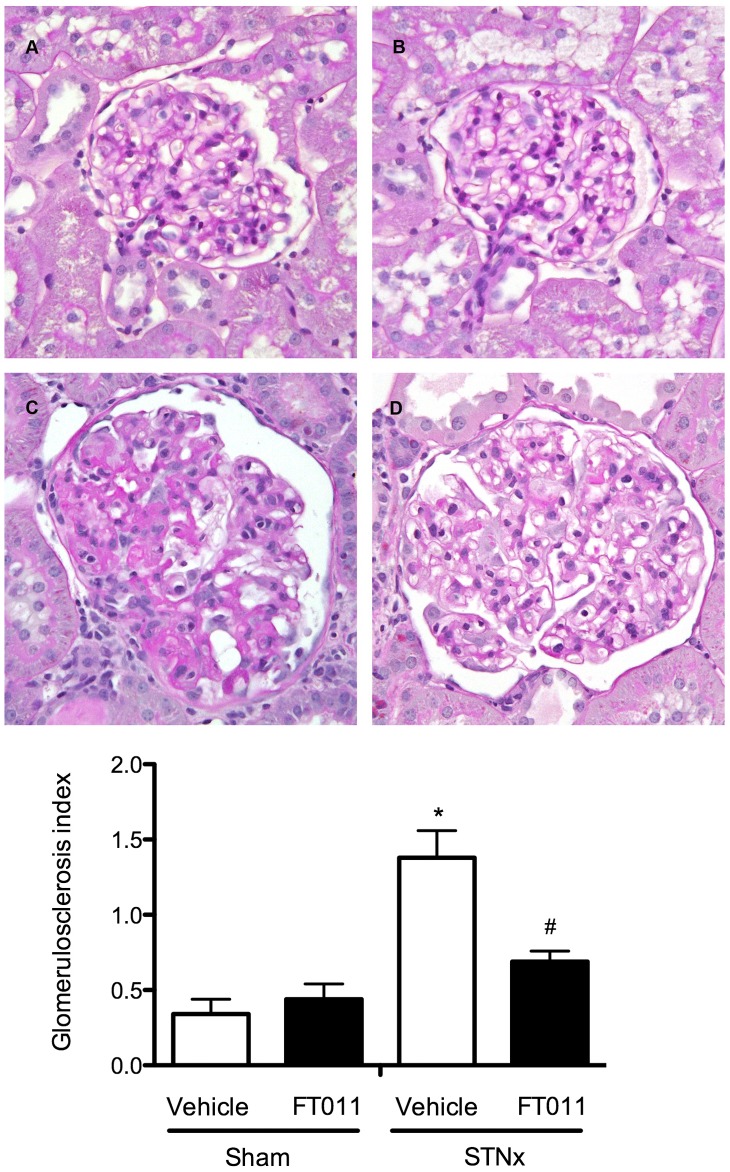
Representative photomicrograph of PAS stained sections from STNx rats.Representative photomicrograph of PAS stained sections from sham and STNx rats treated with and without FT011. In sham (A) and sham treated with FT011 rats (B), there was minimal glomerulosclerosis, while STNx rats (C) was associated with an increase in glomerulosclerosis. Treatment of STNx rats with FT011 (D) was associated with a reduction in extent of glomerulosclerosis. Magnification x400. Glomerulosclerotic index are expressed as mean ± SEM. *P<0.05 compared with sham and sham treated with FT011, #P<0.05 versus untreated STNx rats.